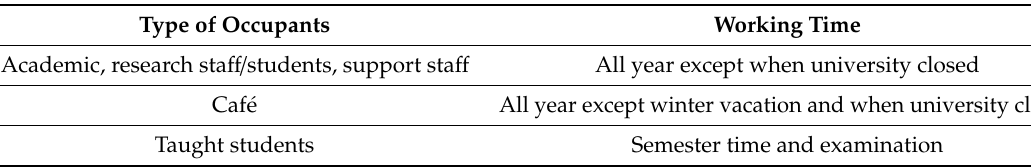
Table A1. Occupants of the Chrystal Macmillan Building.